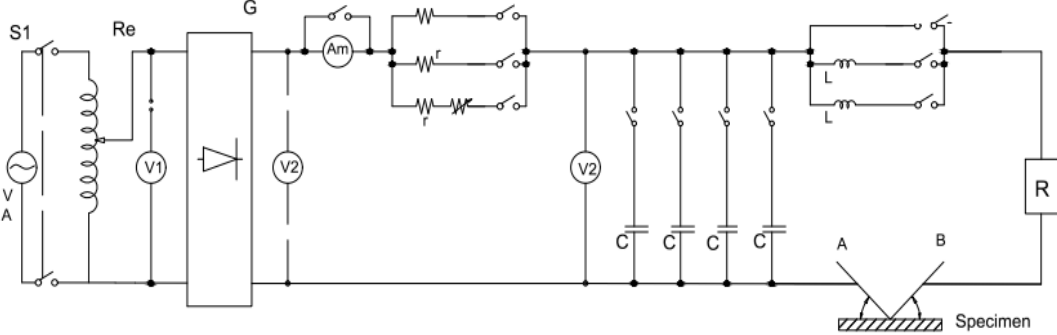
Figure 10. Basic circuit diagram of high current DC arc ignition testing apparatus formed by power switch (S1), regulator (Re), AC voltmeter (V1), rectifier (G), DC voltmeter (V2), DC ammeter (Am), charging resistance (r), capacitor (C), discharge resistance (R), fixed electrode (A), mobile electrode (B) and Inductance for current stabilization (L). Adapted from [112].